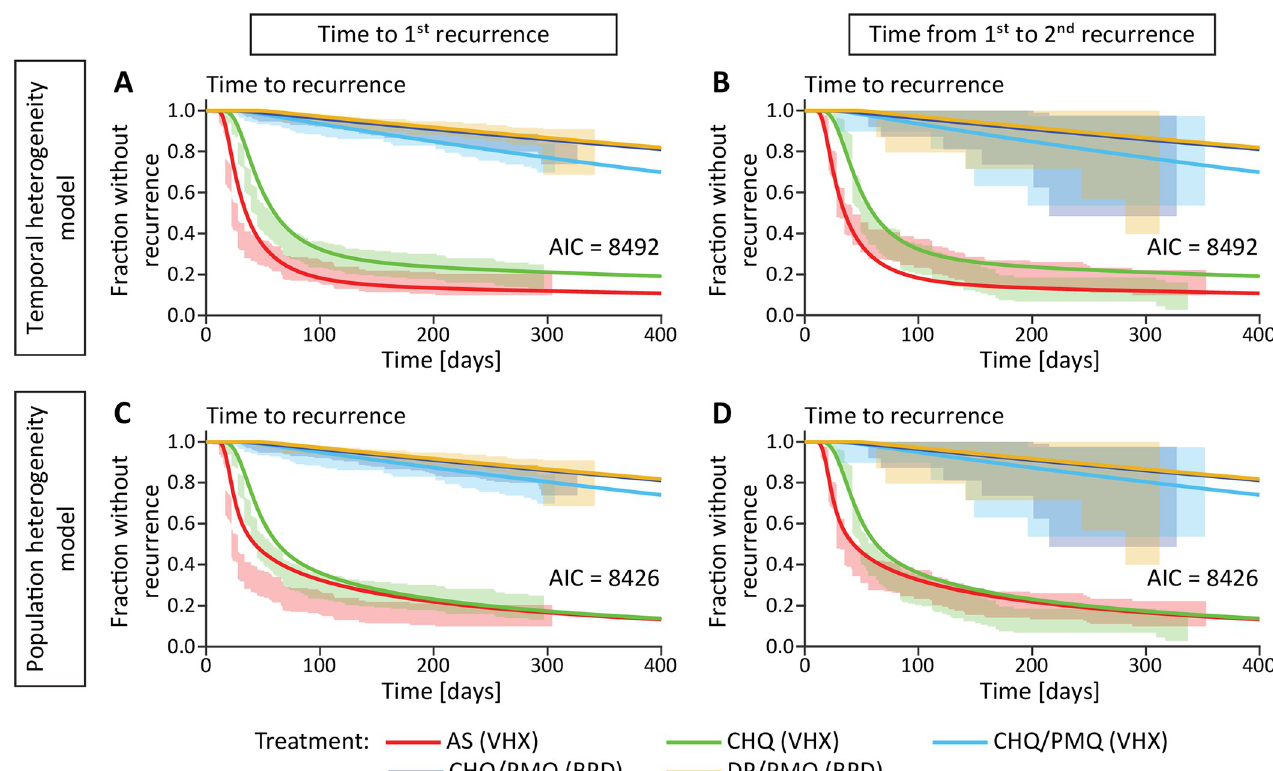
Fig 3. Fitting the temporal and population heterogeneity models to the first and second recurrence time in the Thailand-Myanmar data. Both recurrence times are fitted simultaneously (see Methods and S1 Methods). The lines are the models fitted to the data and the shaded areas are the 95% confidence regions from the data. The left column shows the fit to the first recurrence time and the right column the fit to the time from the first to the second recurrence. The first row shows the temporal heterogeneity model fit and the second row the population heterogeneity model fit. Abbreviations: AS artesunate, CHQ chloroquine, CHQ/PMQ chloroquine and primaquine, DP/PMQ dihydroartemisinin-piperaquine and primaquine, VHX Vivax History study, BPD best Primaquine Dose study.